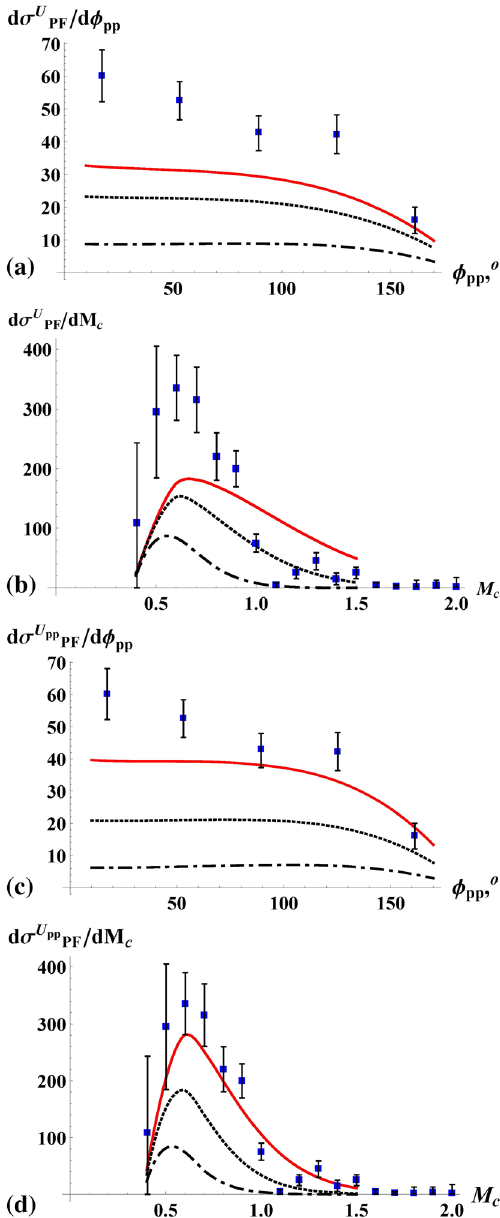
Fig. 7 RB case of the model (see Fig. 3). The data on the process p + √ Fig. 6 PF case of the model (see Fig. 3). The data on the process p + √ p → p + π + + π − + p at s = 200 GeV, | η π | < 1, | η ππ | < 2, p T π > p → p + π + + π − + p at s = 200 GeV, | η π | < 1, | η ππ | < 2, p T π > 0 . 15 GeV, 0 . 005 < − t 1 , 2 < 0 . 03 GeV 2 , (STAR collaboration [17,18]). 0 . 15 GeV, 0 . 005 < − t 1 , 2 < 0 . 03 GeV 2 , (STAR collaboration [17,18]). a , b show the result with all p p and π p rescattering corrections, c , d a , b show the result with all p p and π p rescattering corrections, c , d show the result when we try to fit the data by formulae without π p show the result when we try to fit the data by formulae without π p rescattering terms. Curves from up to down correspond to different rescattering terms. Curves from up to down correspond to different values of the parameter Λ π in the off-shell pion form factor (11): a , b values of the parameter Λ π in the off-shell pion form factor (11): a , b Λ π = 0 . 45 , 0 . 43 , 0 . 4 GeV, c , d Λ π = 0 . 4 , 0 . 37 , 0 . 35 GeV Λ π = 1 . 6 , 1 . 2 , 0 . 8 GeV, c , d Λ π = 1 , 0 . 8 , 0 . 6 GeV shown in Figs. 11, 12). The lower curve underestimates the corresponds to the parameter Λ π , which better fits the STAR data from STAR, ISR and CMS, but it is close to the CDF data on φ pp distribution (but gives higher values for M ππ > data. Interference with resonances and modifications of the 1 GeV as depicted in Fig. 5b), also describes the data of CMS model in the region |ˆ t | ∼ ˆ s / 2 ∼ 1 GeV 2 can change collaboration well (but overestimates the CDF data, as was